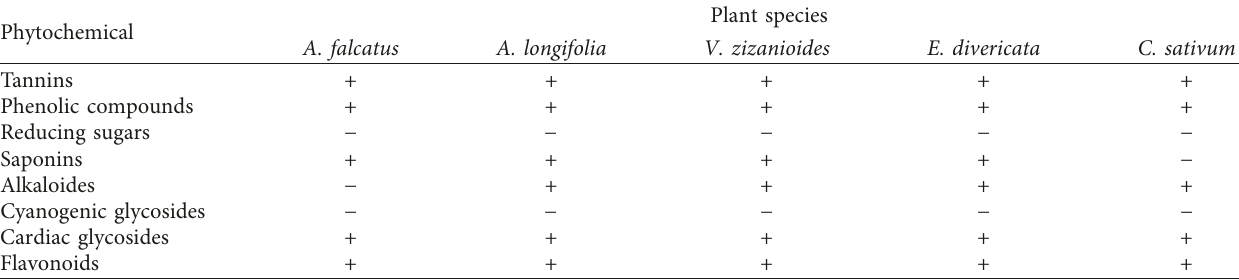
Table 2: Summary of the phytochemicals present in five plant species.